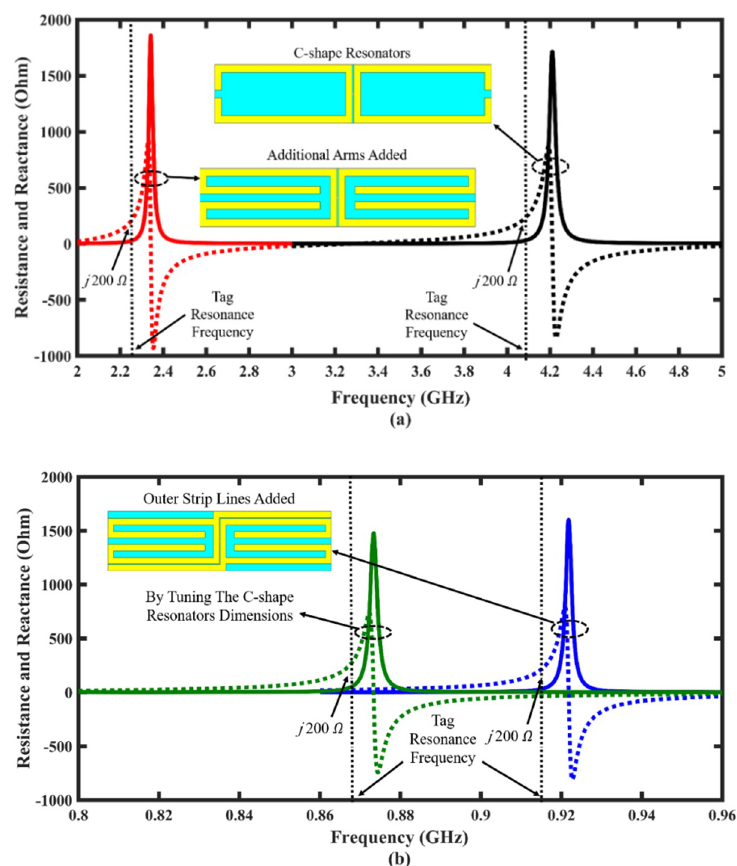
Figure 2. ( a ) input impedance for the stages with C-shaped resonators and additional arms; ( b ) input impedance for the stages with outer strip lines and tuning the dimensions of C-shaped resonators (Solid line: Resistance, Dotted line: Reactance).